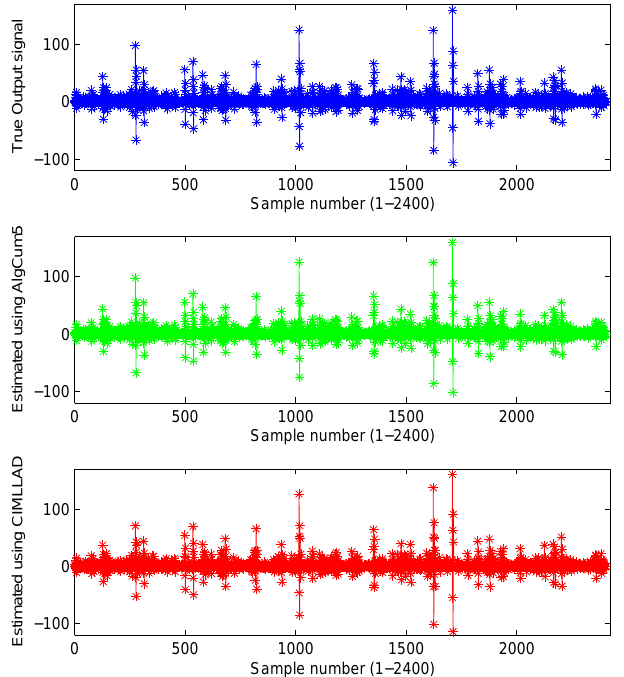
Figure 17. True and estimated output signals for System